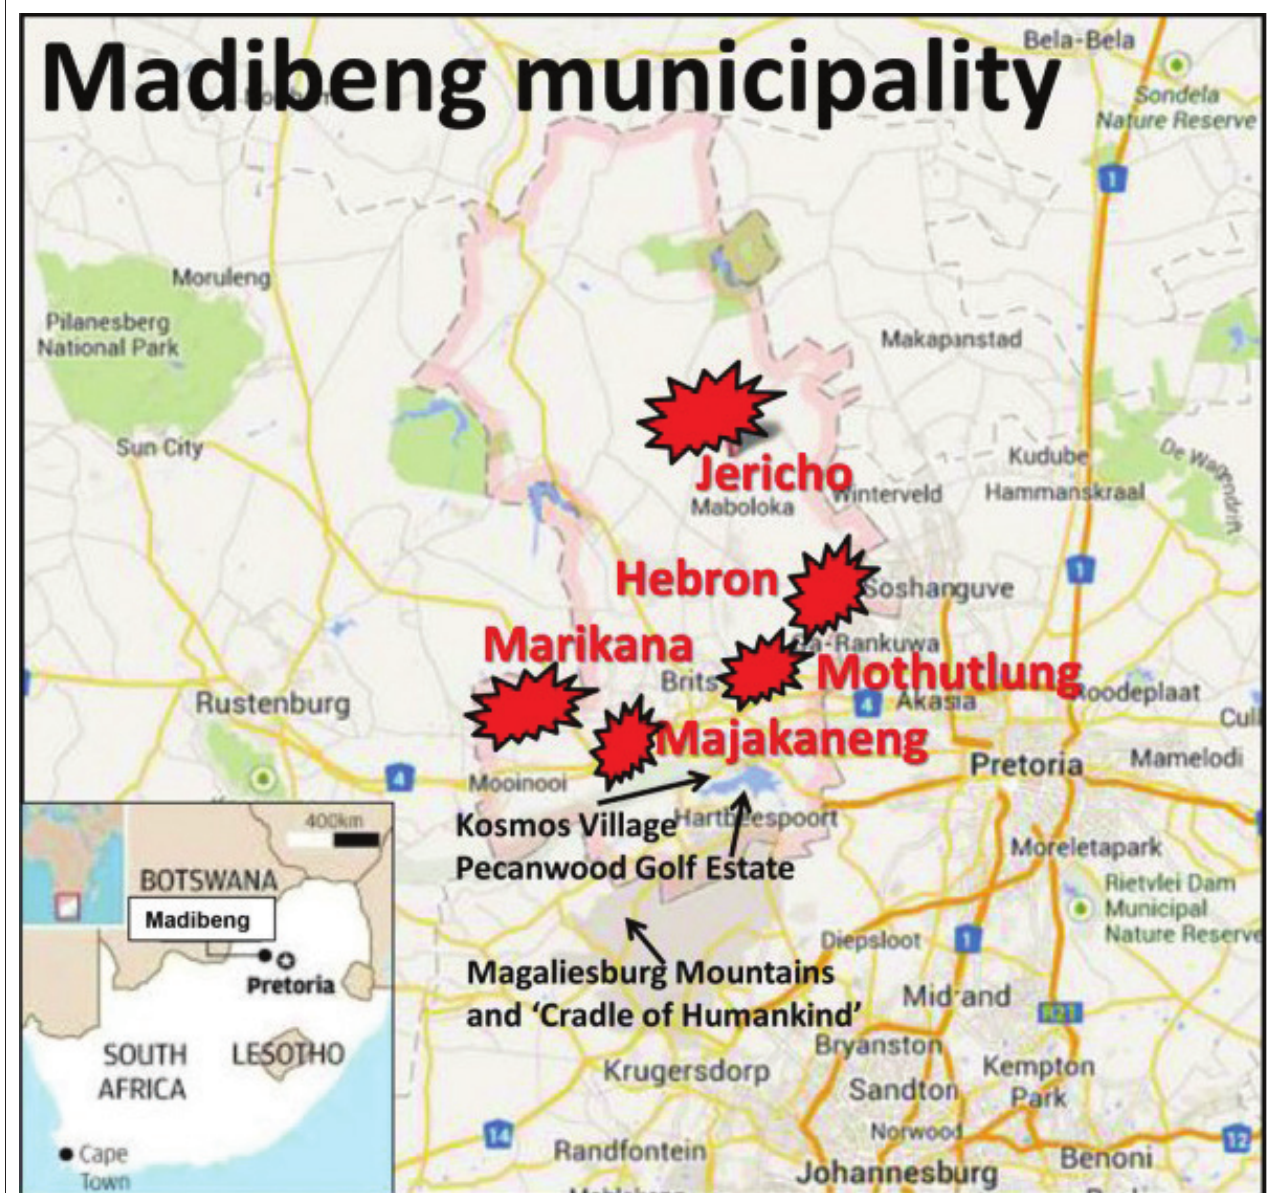
FIG URE 1: Madibeng